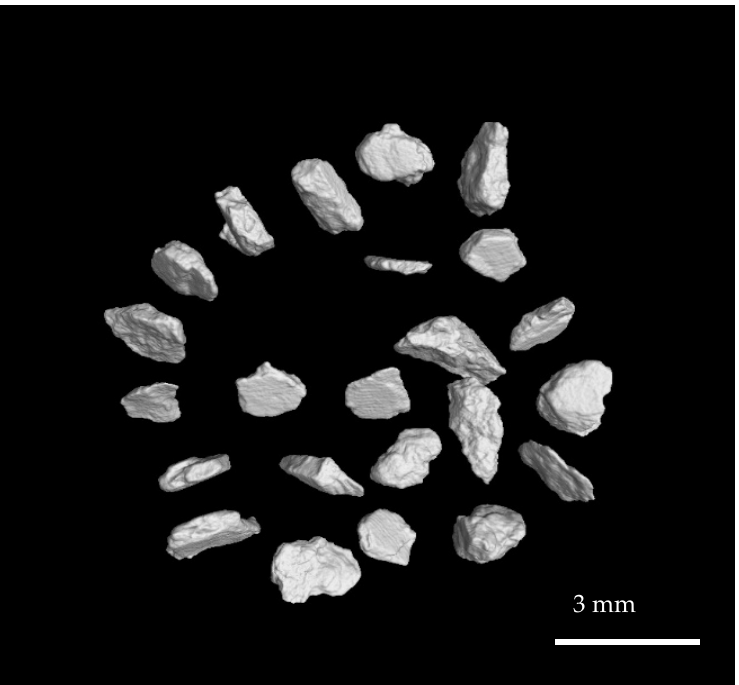
Figure 1. Volume rendering of micro-CT images for a layer of particles (mica of size 0.6~1.18 mm).